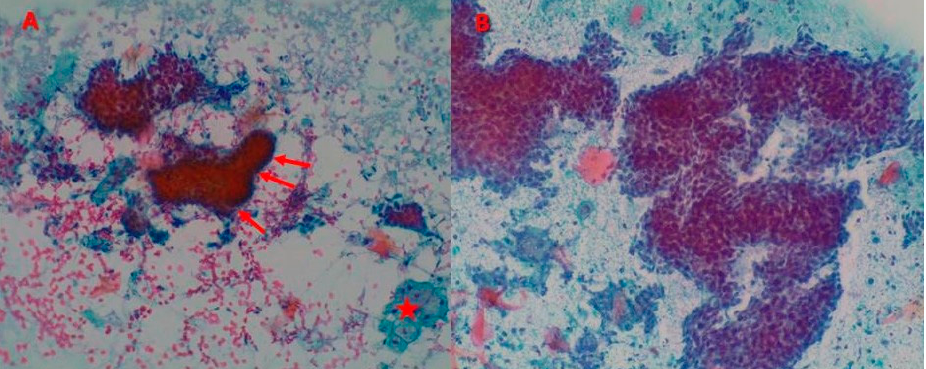
Figure 1. Basal cell cacinomas (BCCs). ( A ) Superficial basal cell carcinoma (sBCC): presence of two fragments composed of tightly packed small cells with mild atypia, peripheral palisade (red arrows), absence of dehiscence, and one cluster of clear sebaceous cells (red star) (Papanicolaou stain, ×100). ( B ) Non-superficial basal cell carcinoma (nsBCC): cellular smear with large clusters of basal cells with dehiscence and severe grade of atypia (Papanicolaou stain, ×200).